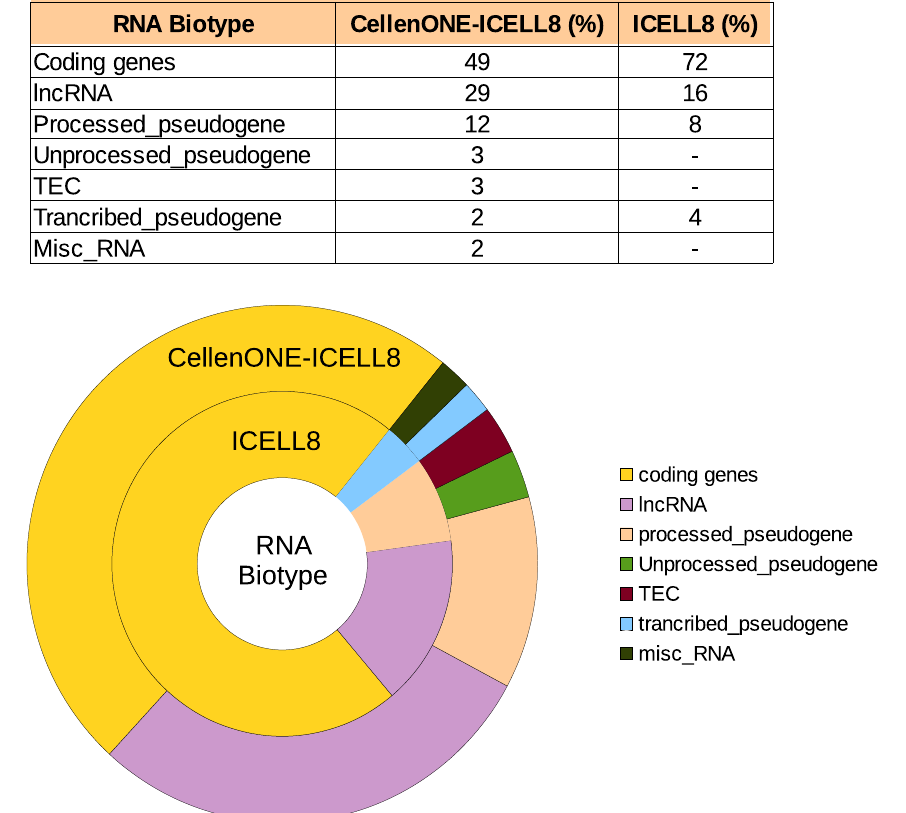
of markers associated with cell death signalling via NRAGE, NRIF, NADE, cell death receptor signalling pathway (MCF2L, OBSCN) and activation of metabolic gene expression (ACACB). Notably, cluster 5 shared regulation of several genes with cluster 2 which represented mainly patient samples GOE1360 and GOE247. For cluster 2 and 5, we found upregulation of genes related to chromatin-remodelling, DNA-repair, nucleosome assembly, cell cycle mitotic/checkpoints, deposition of new CENPA-containing nucleosomes, and signalling by Rho GTPases e.g., CDT1, KNL1, TMPO, GTSE1, H2HX, BRCA2, and SKA1. Based on those differing markers found for the different clusters, it is possible to display genes that, while they may not be markers for all cells within a sample, they do show particular patterns that can be linked with different progeria phenotypes. Variant‑associated expression signatures in accelerated ageing phenotypes. We next inves- tigated the extent to which additional variant heterogeneity in putative driver genes could be associated with transcriptional heterogeneity for ageing processes in each case. It is important to note that this analysis was done in a hypothesis-free way, not taking into account the underlying primary genetic cause and mutation of the age- ing phenotype, and thereby, being able to search for additive and overlapping variant signatures and expression profiles associated with general aspects of premature ageing. In order to evaluate how genetic regulation drives specific ageing phenotypes, we searched for patient-specific variants or non-uniformly distributed variants expressed in each of the six patients with different segmental progeria syndromes. We first combined all variant calling files (VCFs) from both single-cell and bulk RNA-seq data, initially detecting variants in each of the scRNA-Seq samples. Most of the variants were found uniformly distributed, suggesting common effects across all samples related to ageing disease (SNPs and INDELS). Because the detec- tion of SNPs on the scRNA-seq produces many false positives and many of the variants exhibited relatively low depth (1 or 2 reads with a variation), we selected additional criteria to label “mutant cells” considering filtering based on variant- and total depth. To optimize depth cutoffs, the quartile distributions of the variant and total depths were calculated for each sample. Variants were filtered for variant depths > 4 (i.e., number of reads containing the variant base) and total depths > 7 (i.e., number of all reads at variant position) in the scRNA-seq data. All variants reported in this study have later been corroborated by the bulk RNA-seq data while filtering variants in the bulk data for